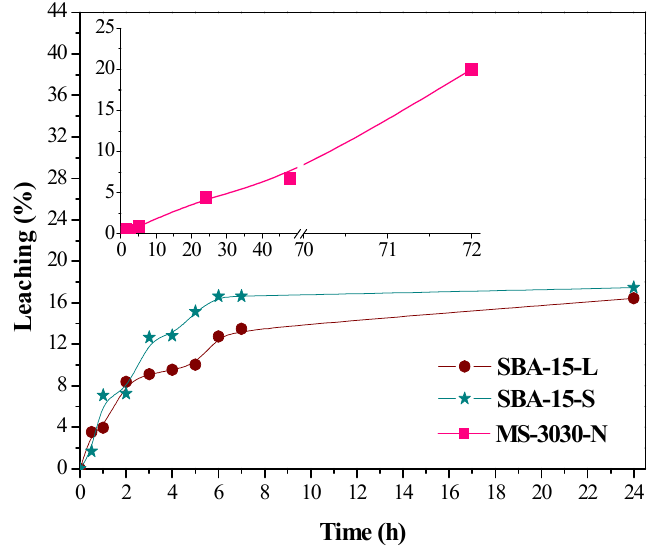
Figure 8. Leaching of enzyme from materials, expressed as percent of the initial enzyme loading released as a function of